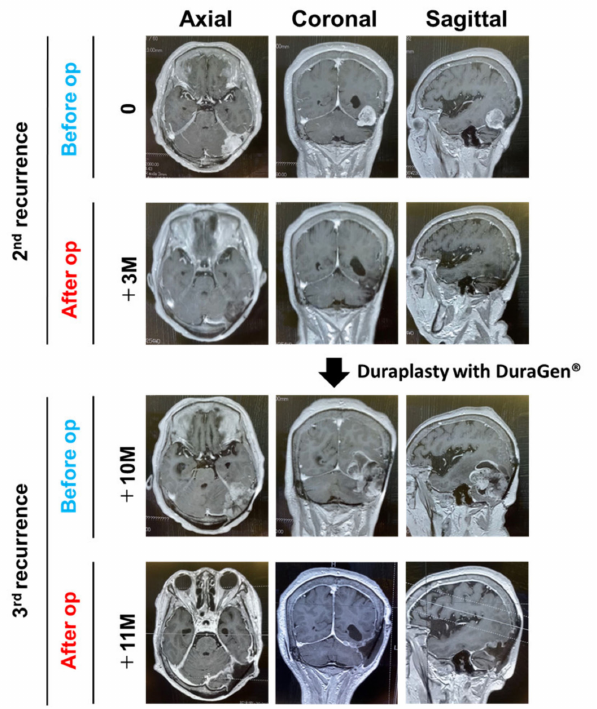
Figure 1. Radiographical images. Preoperative and postoperative gadolinium-enhanced T1-weighted imaging at the 2nd and 3rd recurrences are shown (axial, coronal, and sagittal views). DuraGen ® was placed to achieve duraplasty at the operation for the 2nd recurrence. op,